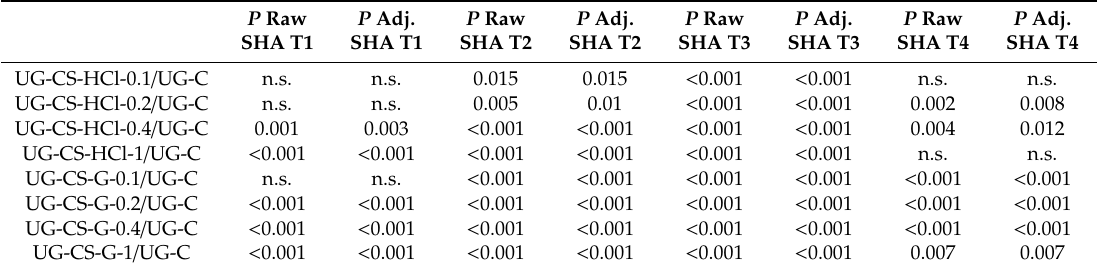
Table 2. Shore A hardness p -values ( ≤ 0.05) raw and adjusted (adj.) by Bonferroni–Holm correction for Ufi Gel